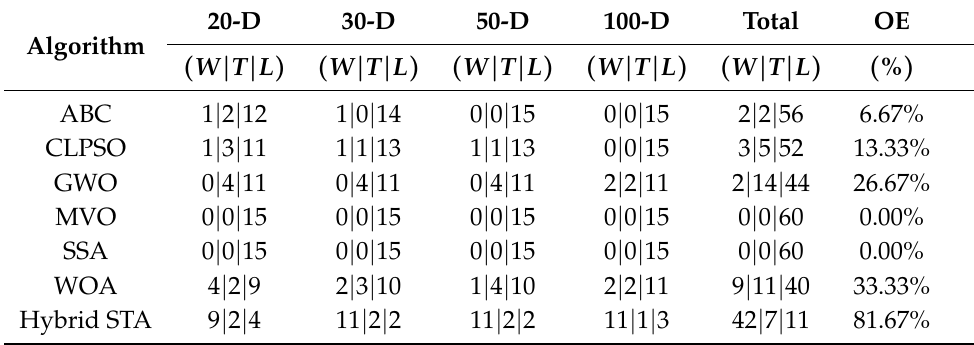
Table 8. The overall effectiveness of the hybrid STA and competitor algorithms.